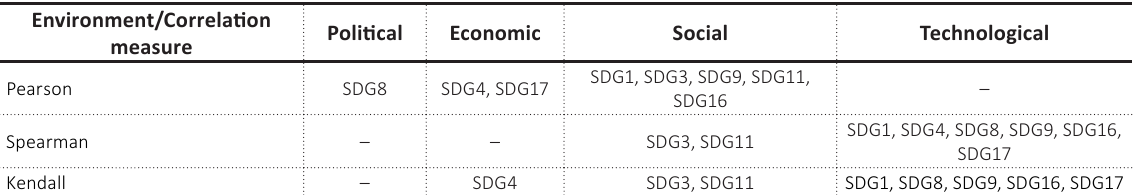
Table 6. Assignment of SDGs to different FinTech environments according to the correlation strength